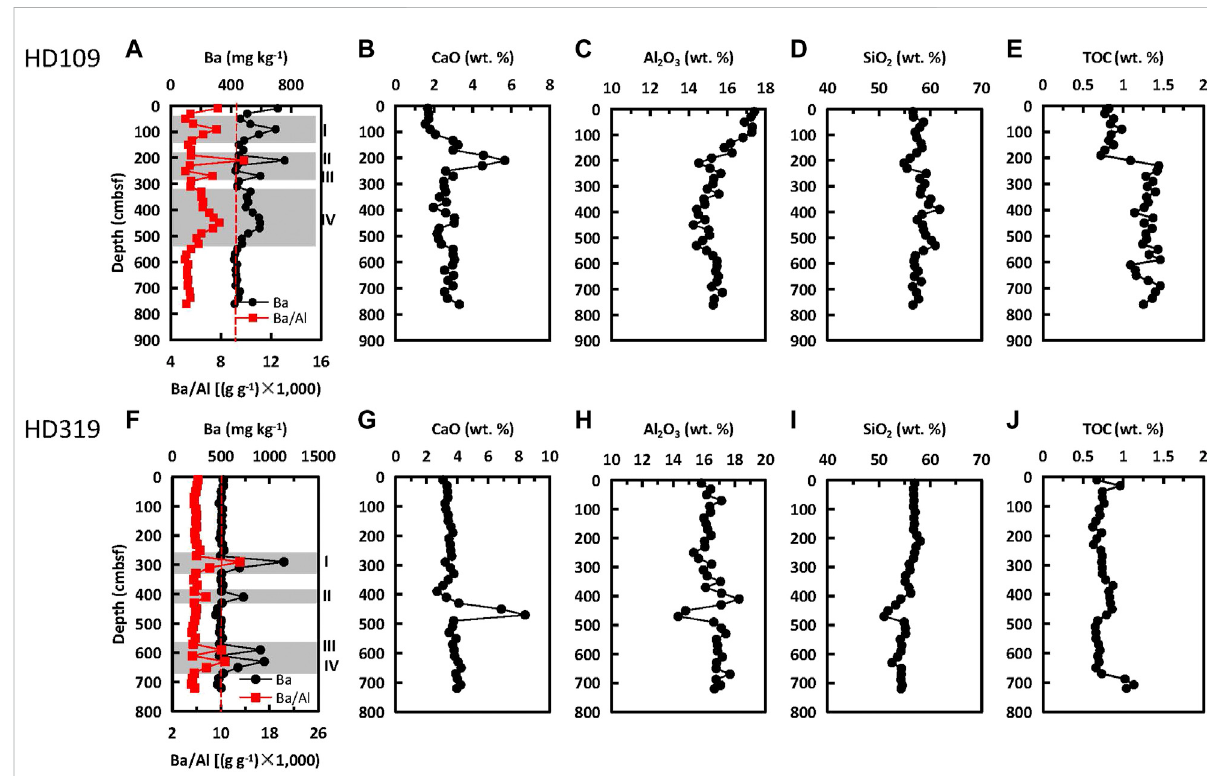
FIGURE 3 Depth pro fi les for the contents of Ba (A,F) , CaO (B,G) , Al 2 O 3 (C,H) , SiO 2 (D,I) , TOC (E,J) and Ba/Al ratio (A,F) at cores HD109 and HD319. The shaded intervals I to IV (A,F) refer to Ba fronts. The red vertical lines (A,F) refer to the background values of